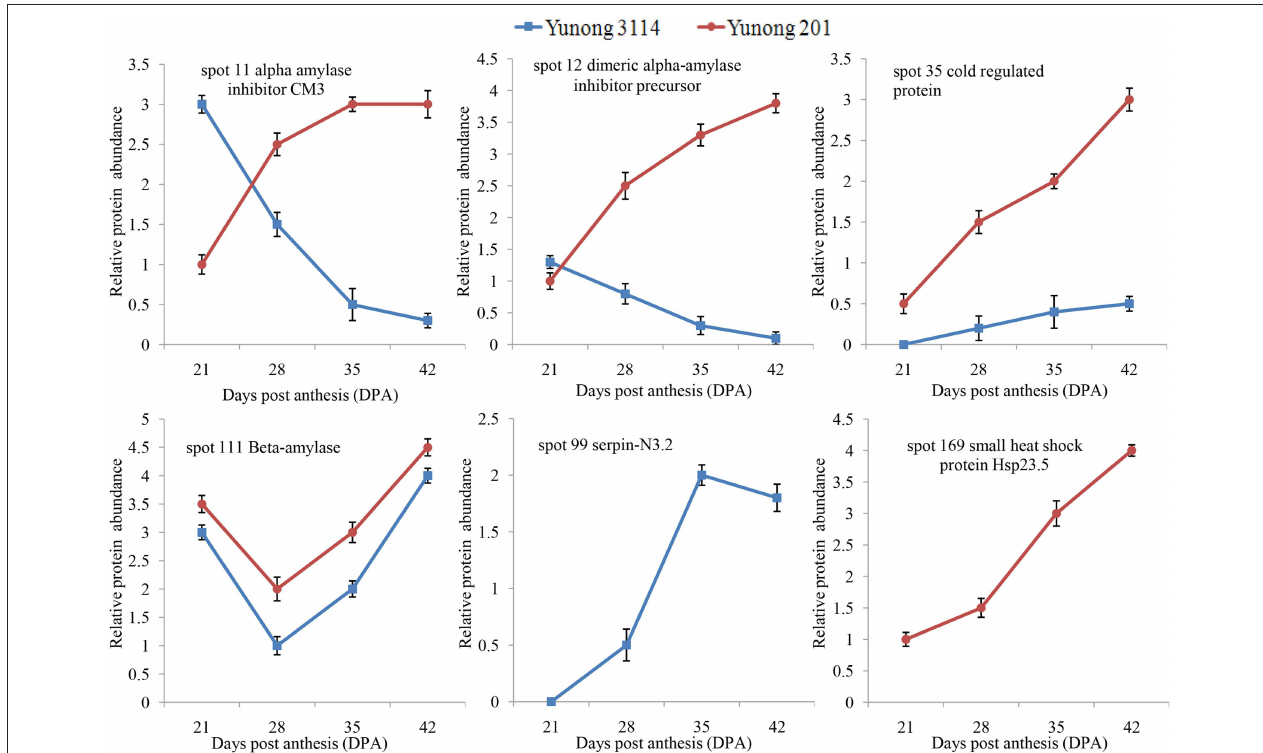
FIGURE 6 | Differential expression of six protein spots in Yunong 201 and Yunong 3114 during four grain developmental